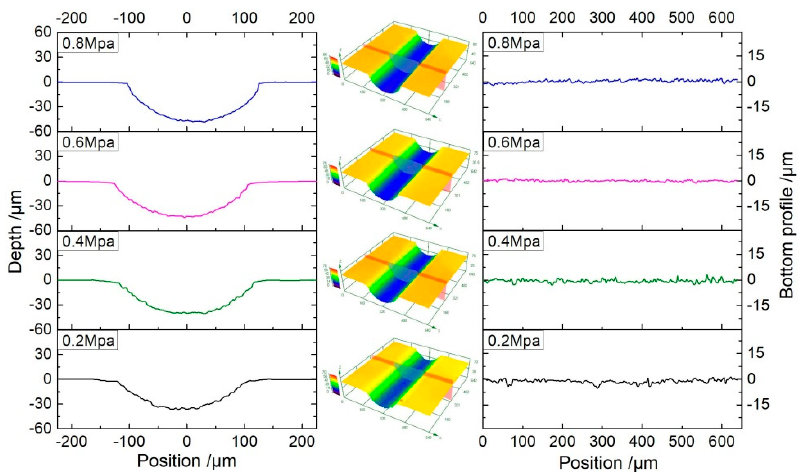
Figure 9. The profiles of micro-grooves generated with different electrolyte pressures ( U = 35 V, ε = 20%, f = 1 kHz, t on = 20 s).